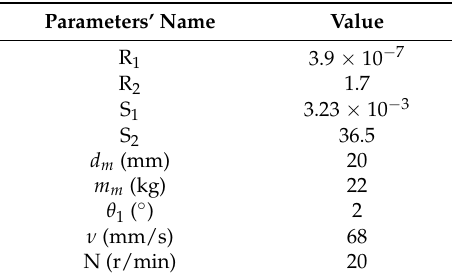
Table 4. Parameters of bearing.